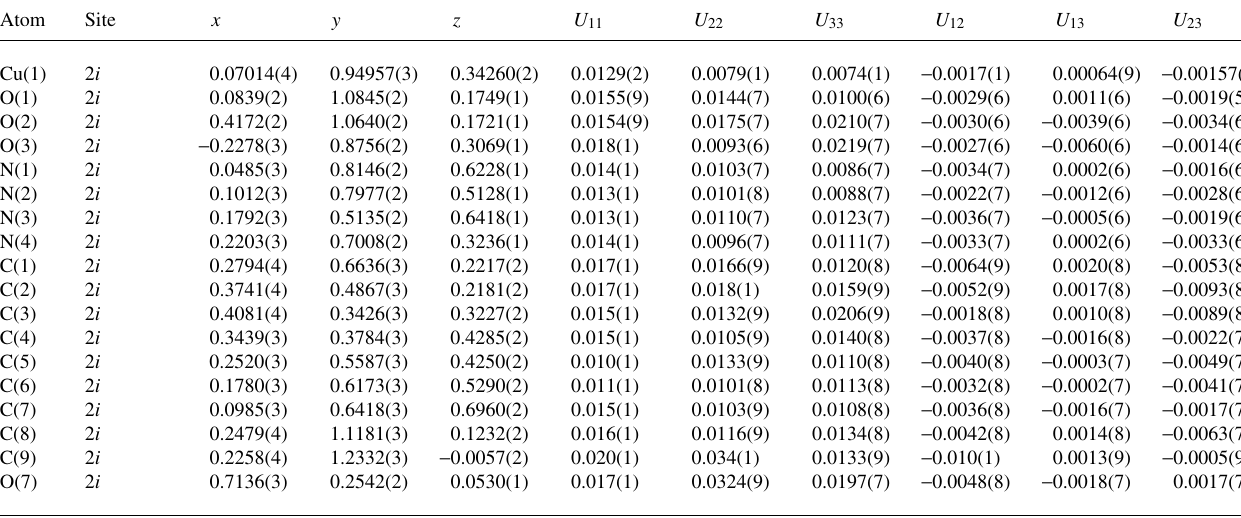
Table 3. Atomic coordinates and displacement parameters (in Å 2 ) .